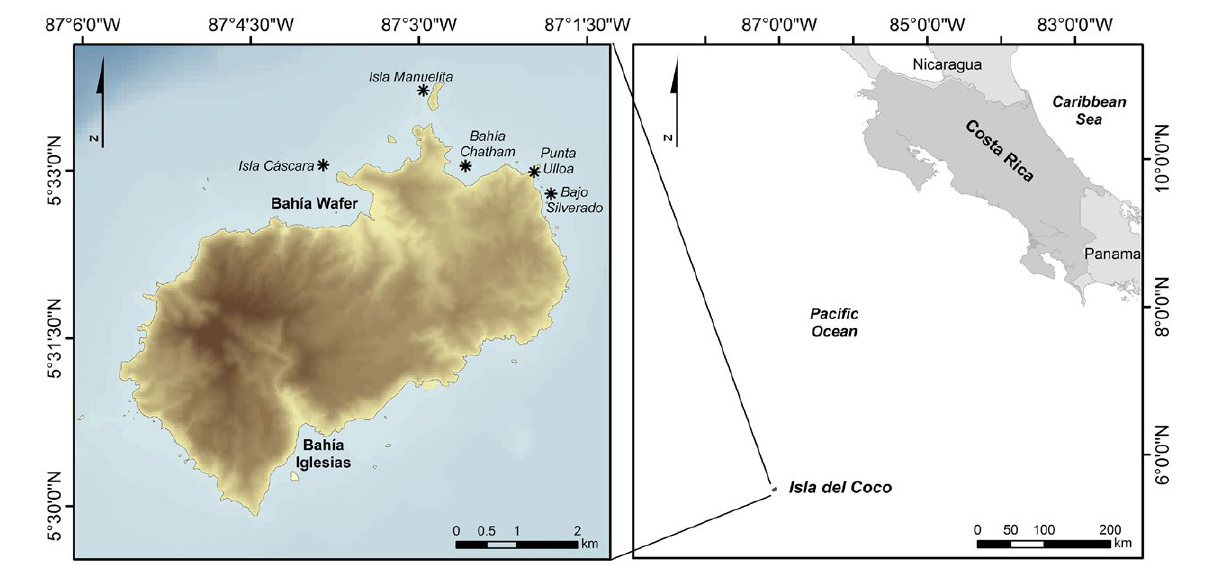
Figure 1. Isla del Coco, showing sites* at which Heteromysis ( Olivemysis ) cocoensis n. sp. was